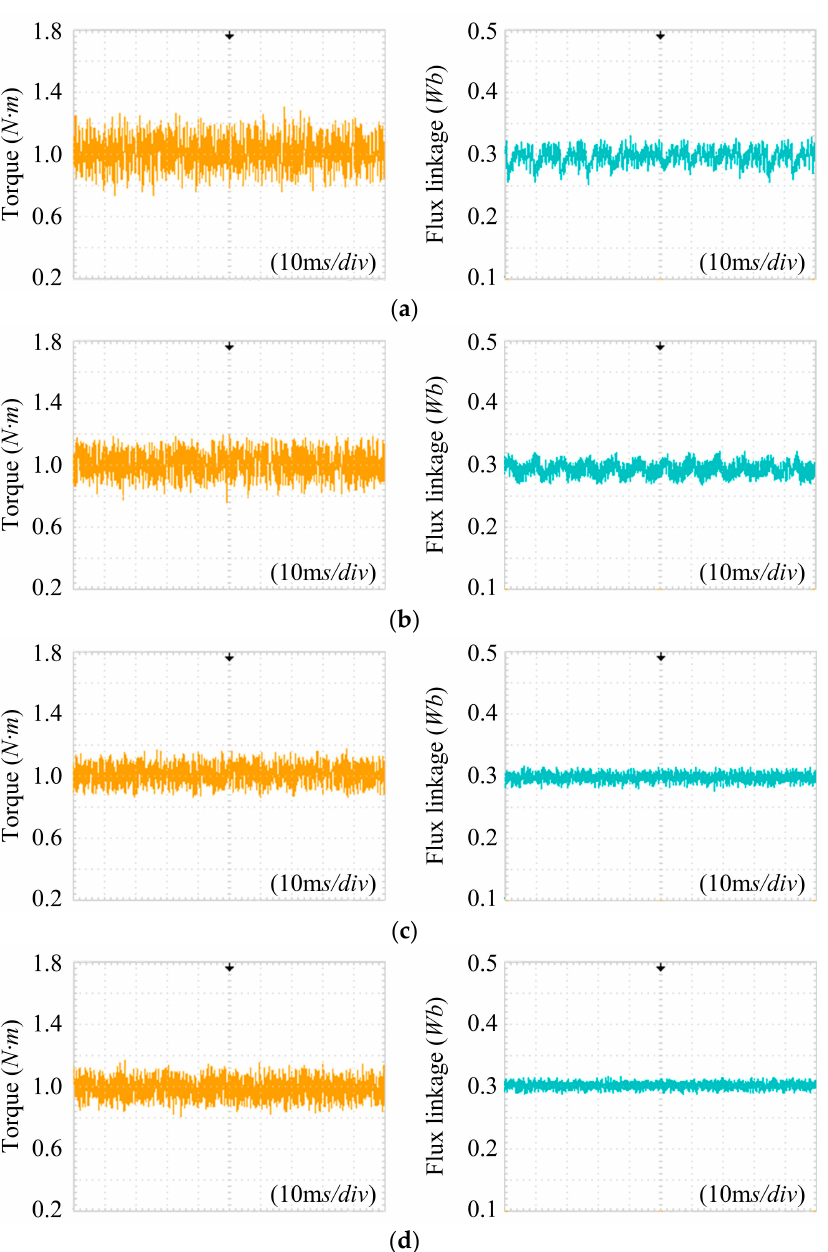
Figure 13. Experimental torque and flux of the PMSM when using: ( a ) CDTC; ( b ) DDTC; ( c ) SVM-DTC; ( d ) CVM-DTC.